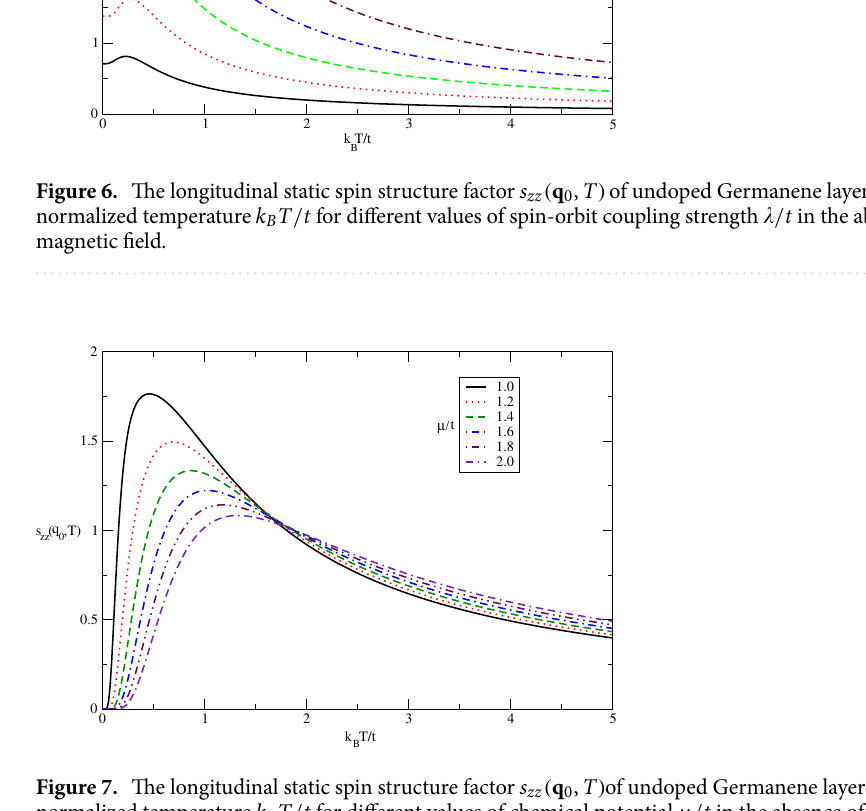
Figure 7. The longitudinal static spin structure factor s zz ( q 0 , T ) of undoped Germanene layer versus normalized temperature k B T / t for different values of chemical potential µ/ t in the absence of magnetic field. 0.4 Spin-orbit coupling strength has been fixed at (cid:31) / t =